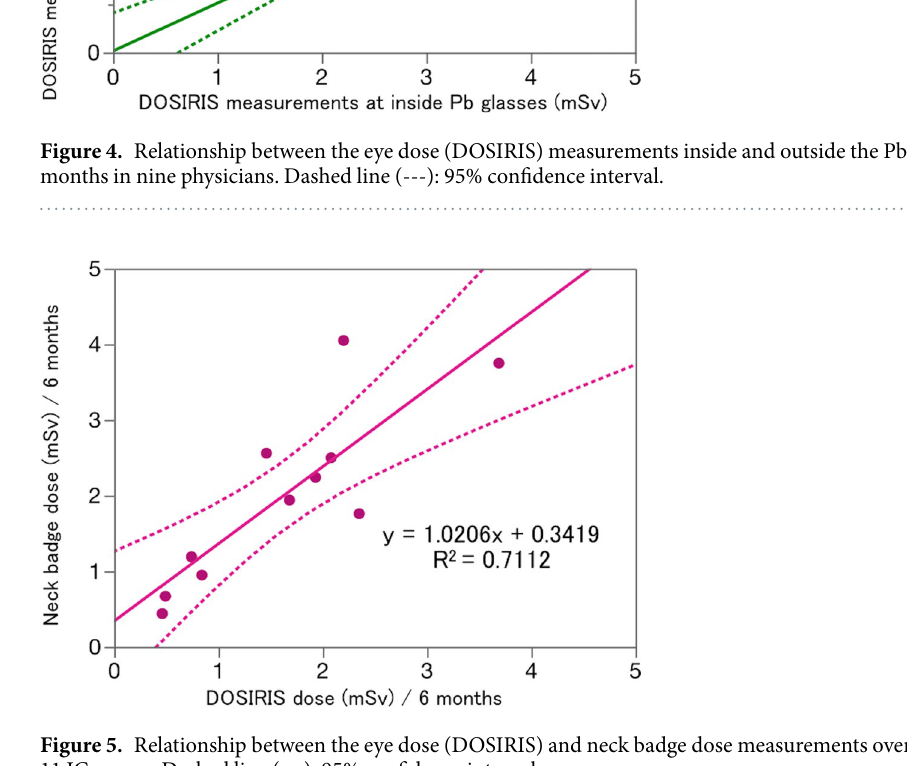
Figure 5. Relationship between the eye dose (DOSIRIS) and neck badge dose measurements over 6 months in 11 IC nurses. Dashed line (---): 95% confidence